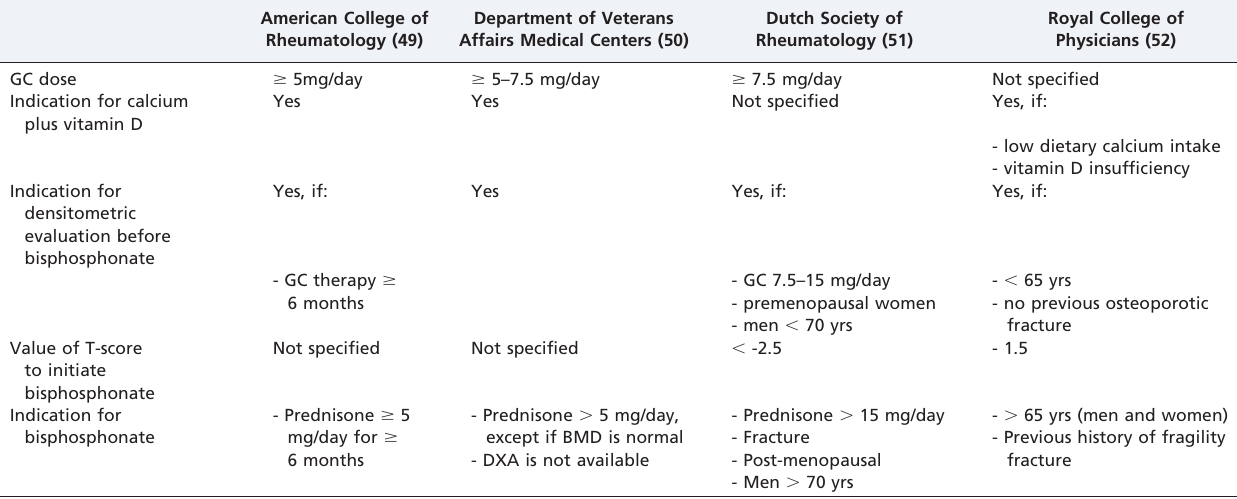
Table 4 - Guidelines for the prevention of GIO.